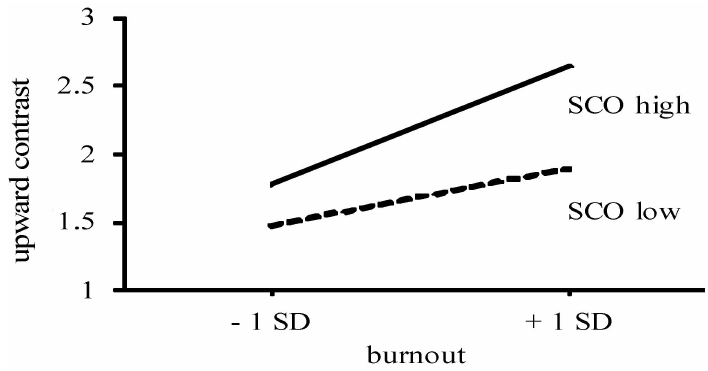
Figure 2. Upward contrast as a function of burnout and SCO